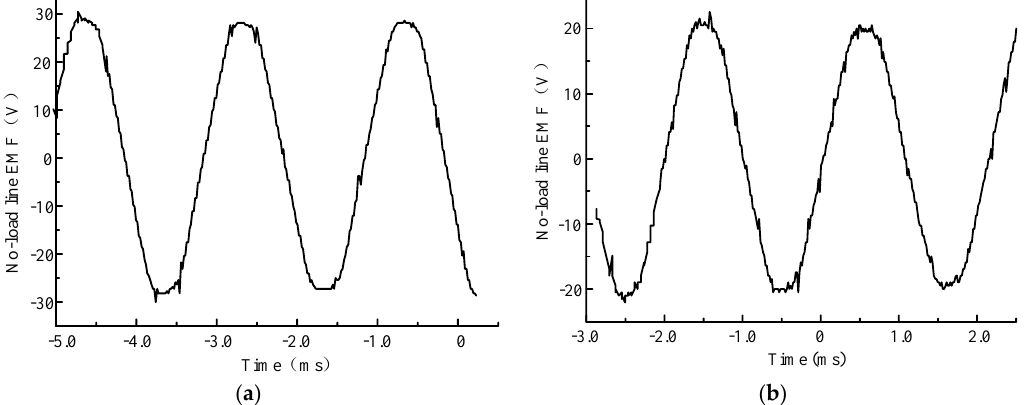
Figure 18. Measured no-load line EMF curves: ( a ) measured no-load line EMF curves of improved winding; ( b ) measured no-load line EMF curves of distributed winding.